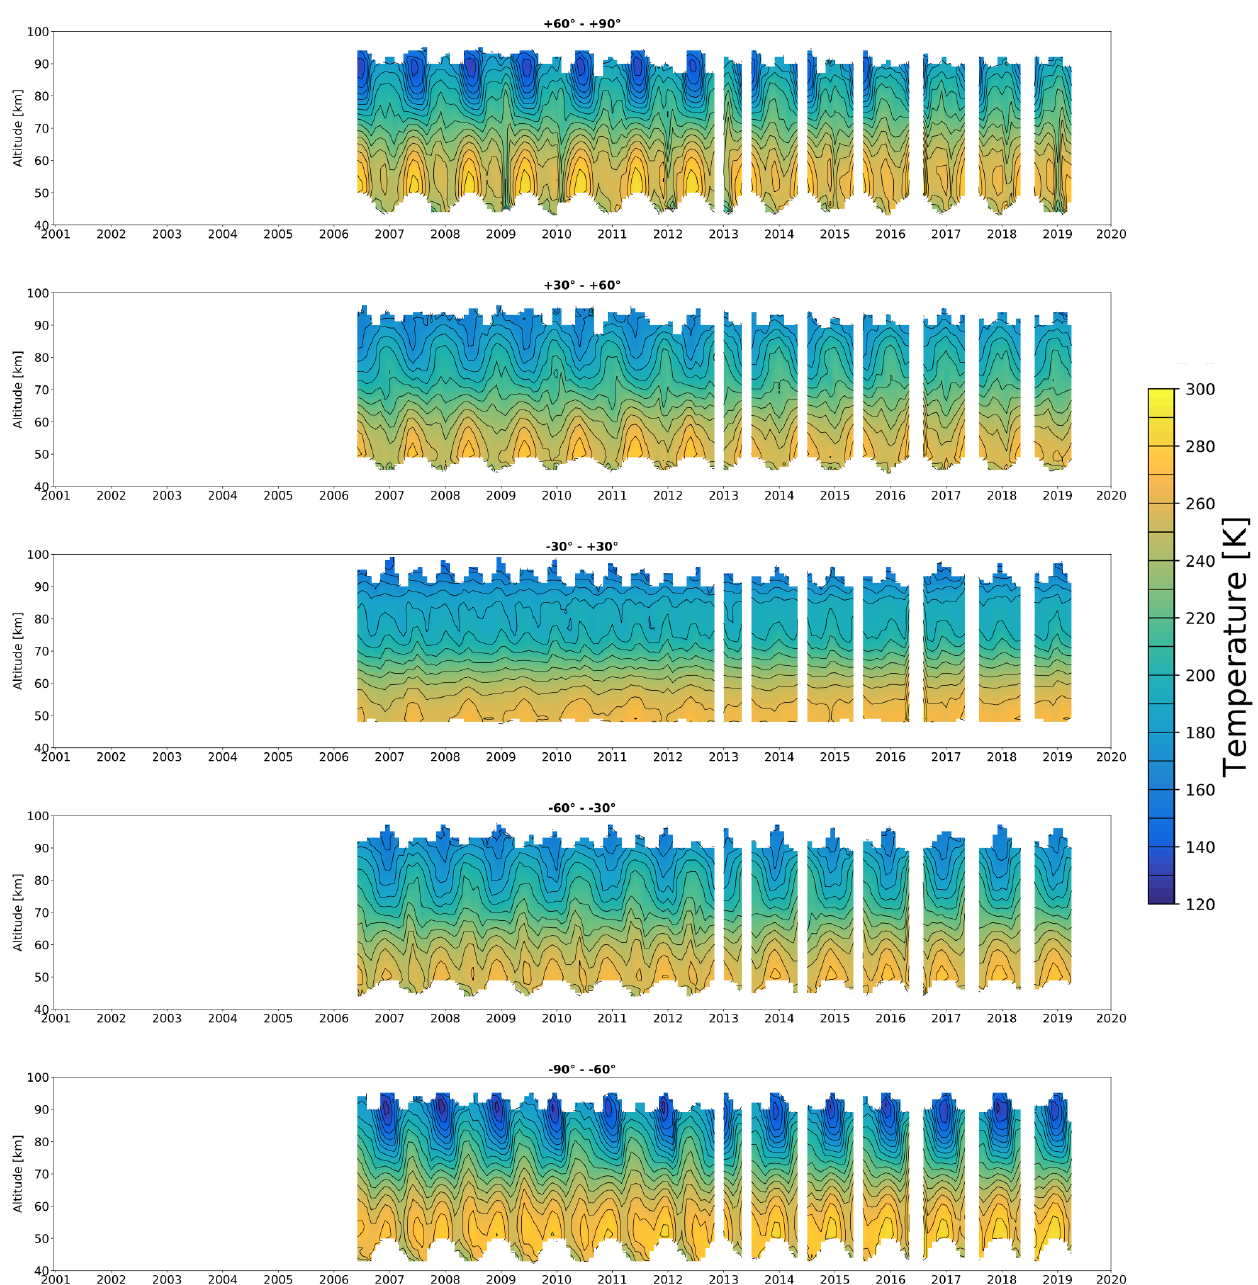
Figure A2. Time series of FM13 temperature measured by SMR for different latitude bands. The white areas indicate periods and altitudes at which the number of measurements in the given latitude band is lower than 10. The ticks on the x axis correspond to the beginning of each